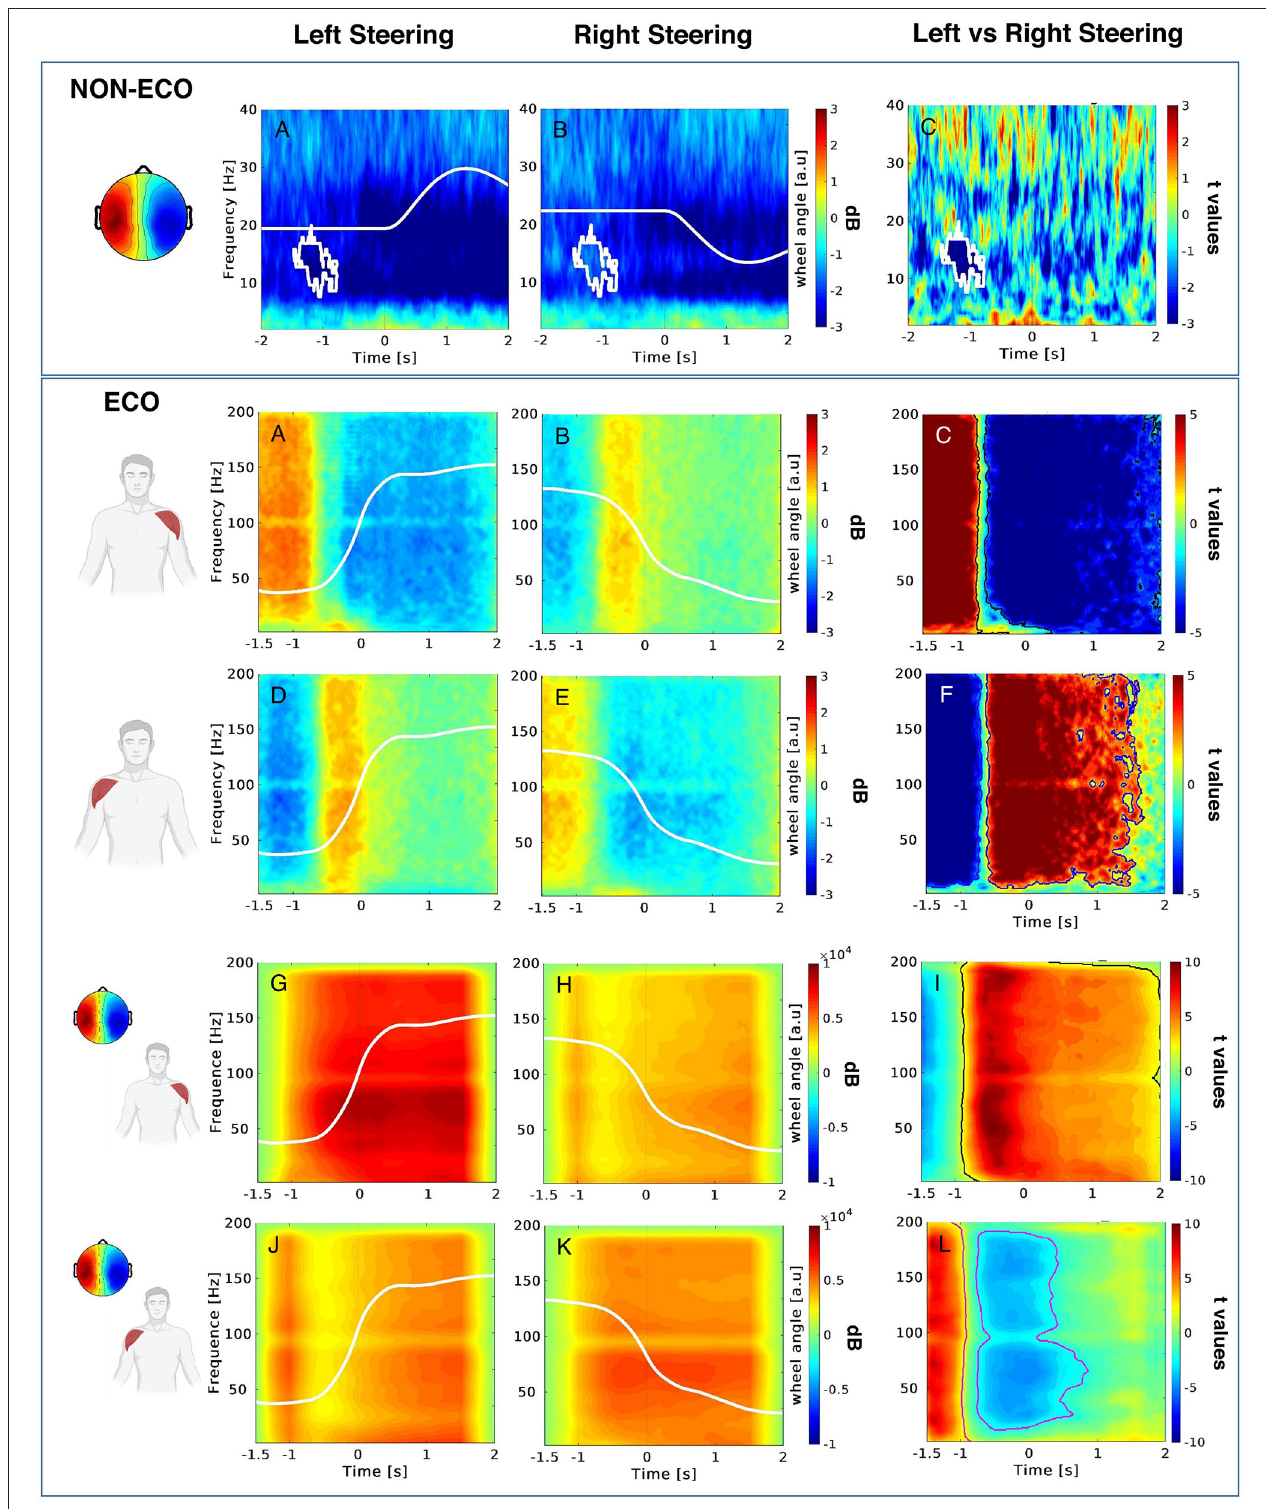
FIGURE 1 | NON-ECO frame. Time-frequency EEG patterns collected during left (A) and right (B) non-ecological steering, as well as their statistical comparison (C) . The topography in the left part of the picture shows the average scalp map related to the cluster of independent components. ECO frame. ERSP for the EMG signals